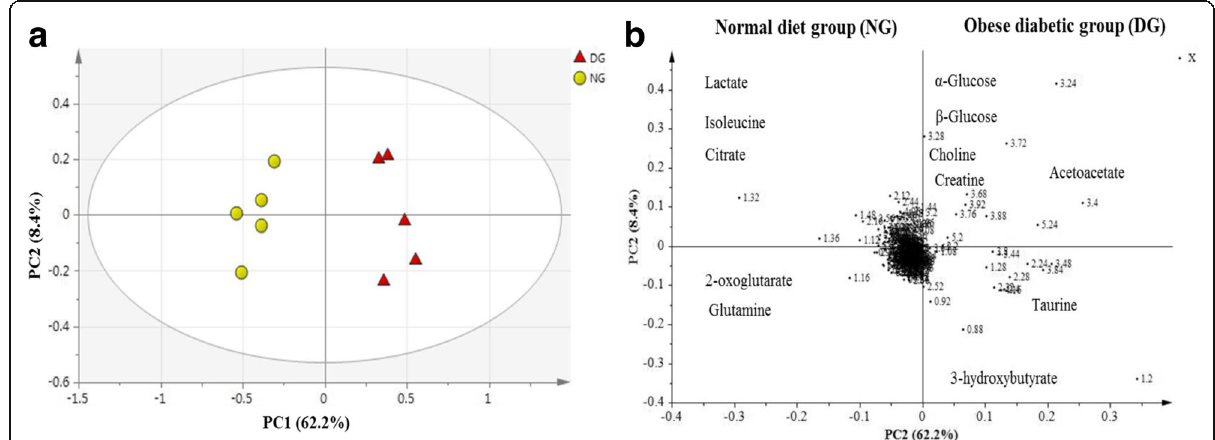
Fig. 7 PCA score plot ( a ), loading plot ( b ) obtained using 1 H NMR data for serum samples from Sprague-Dawley rats, obese diabetic group (DG) and normal diet group (NG) before